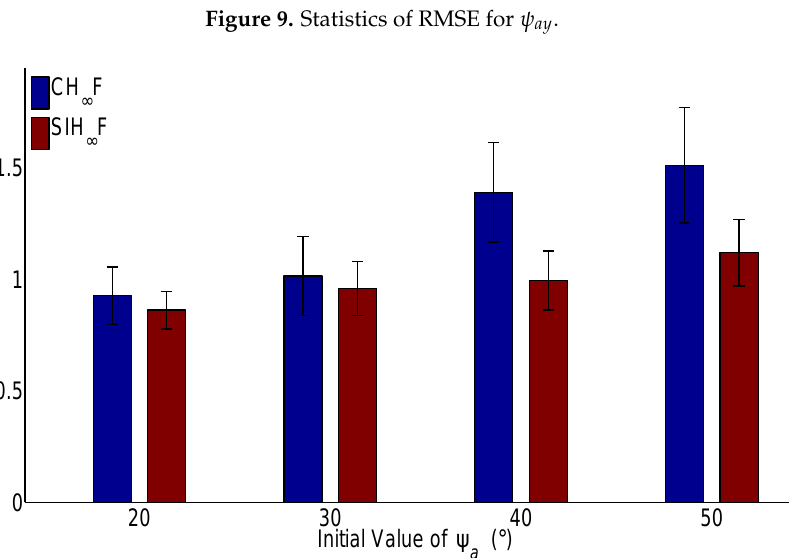
Figure 9. Statistics of RMSE for ψ ay .